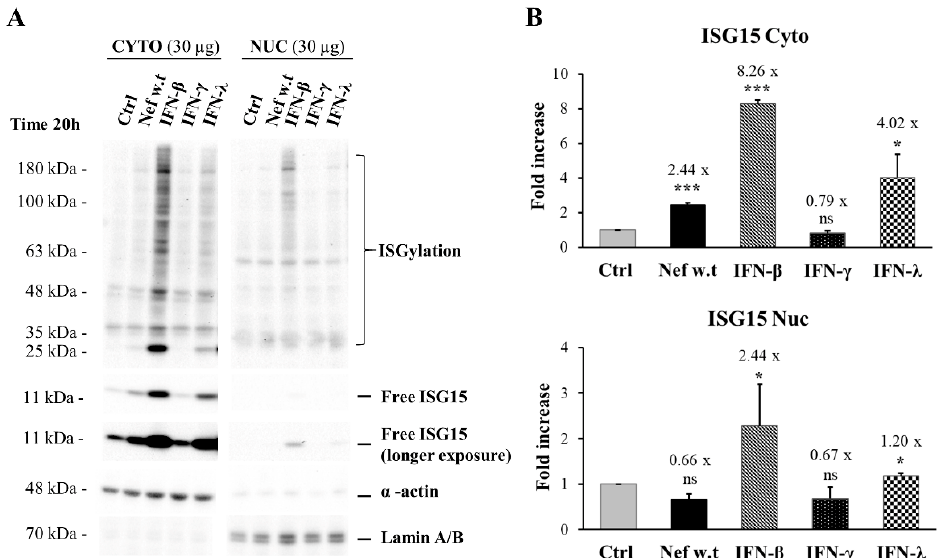
Figure 6. HIV-1 myrNef SF2 w.t protein induces the production of ISG15, which is mainly localized in the cytoplasmic fraction. A total of 4 × 10 6 GEN2.2 cells were treated with myrNef SF2 w.t (300 ng/mL), IFN- β (1000 IU/mL), - γ (100 ng/mL) or – λ 1/ λ 2 (100 ng/mL) or left untreated (Ctrl) for 20 h. Cells were lysed and 30 µg of proteins for each sample were run on 9–13.5% SDS-PAGE gel. ( A ) A representative Western blot is shown. ( B ) Densitometric analyses of three independent Western blotting experiments are shown. The band density ratio of free ISG15 in the cytoplasmic (Cyto) and nuclear (Nuc) fraction, normalized to relative actin or lamin A/B, respectively, are reported in the histograms. ISG15/actin ratio in control cells (Ctrl) was set to 1. Fold increases after the addition of the indicated treatments was calculated and reported as means ± S.D. One-way ANOVA test; *, p < 0.05; ***, p < 0.005, ns = not significant vs. respective Ctrl.